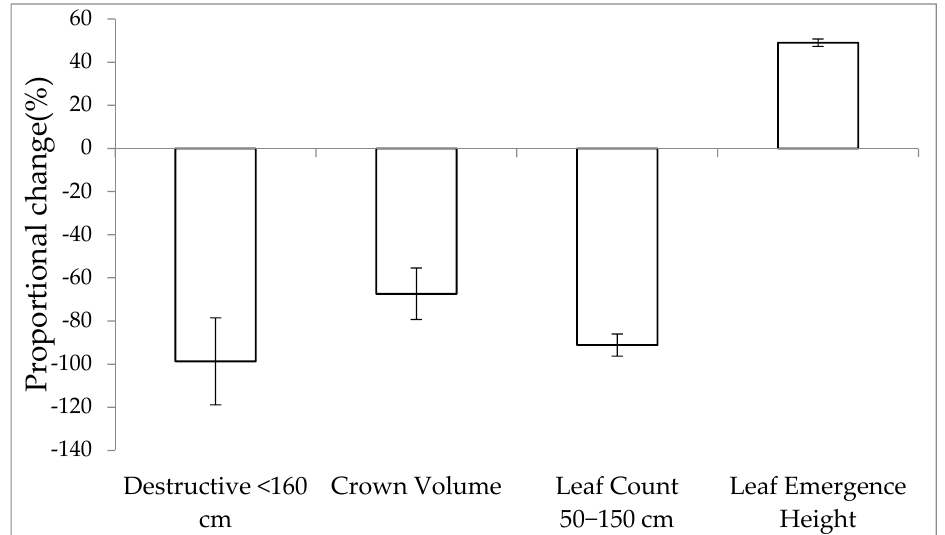
Figure A1. Proportional change (%) of Erythrina berteroana biomass for four assessment methodolo- gies used to detect biomass removal following cattle browsing.